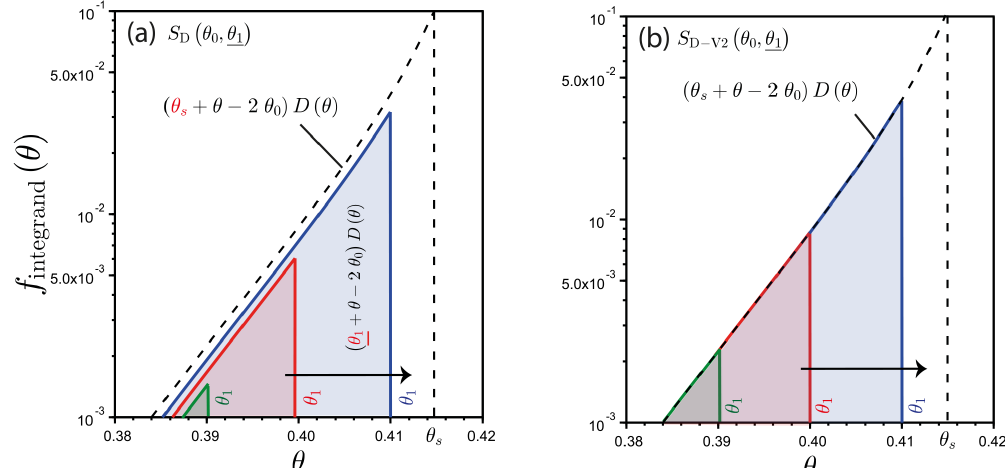
Figure 3. Illustration of the regular strategies for estimating the limits for the case of saturation θ 1 → θ s , with the estimation of S u (θ 0 ,θ s ) using either S D (θ 0 ,θ 1 ) , Eq. (4), (a) or S D-V2 (θ 0 ,θ 1 ) , Eq. (22), (b) . The integration proceeds from the given value of θ 1 to the left, θ ≥ θ 1 , defining the solid zones. The values of θ 1 are increased step by step to reach S u (θ 0 ,θ s ) (see the arrow and the extension of the solid zones). In the equations, the variables that are varied to reach the targeted limits are underlined, and figures are zoomed in on in the vicinity of the limits. The differences in equations between the target and the integrated integrands are in red. An illustrative case of the computation of the limits of S D (θ 0 ,θ 1 ) or S D-V2 (θ 0 ,θ 1 ) for a synthetic loamy soil with an initial water content of θ 0 = 0 . 25; successive values are considered for the final water contents, θ 1 ∈ { 0 . 39 , 0 . 40 , 0 . 41 }